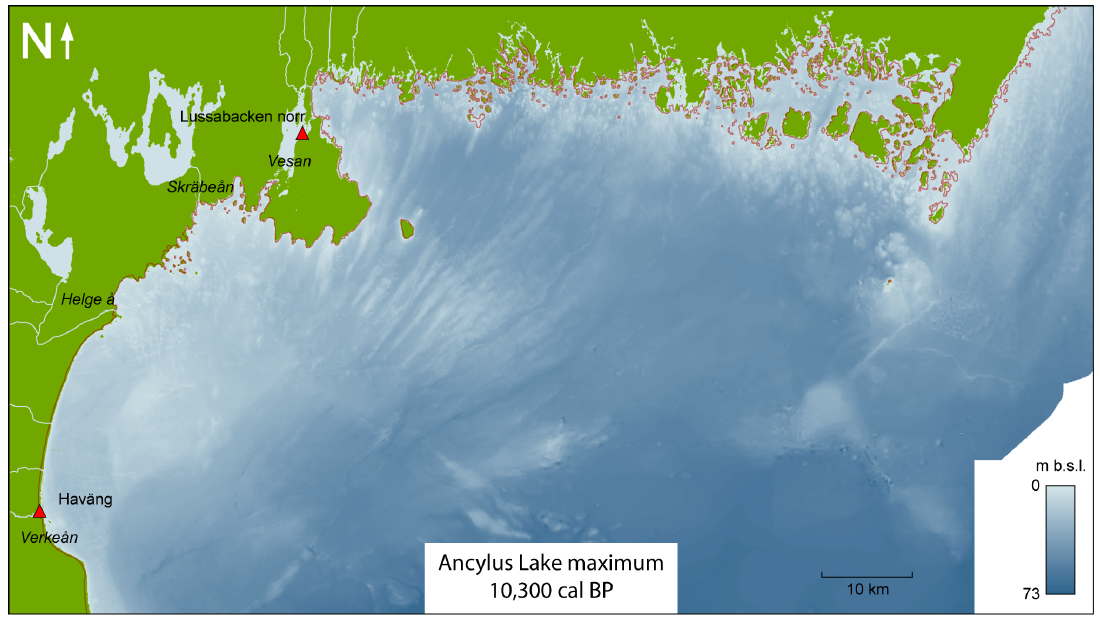
Figure 8. Palaeo-shoreline reconstruction of the study area during the Ancylus Lake maximum. The red line represents the present coastline. The red triangle represents the archaeological site discussed in the text. Light blue lines represent rivers discussed in the